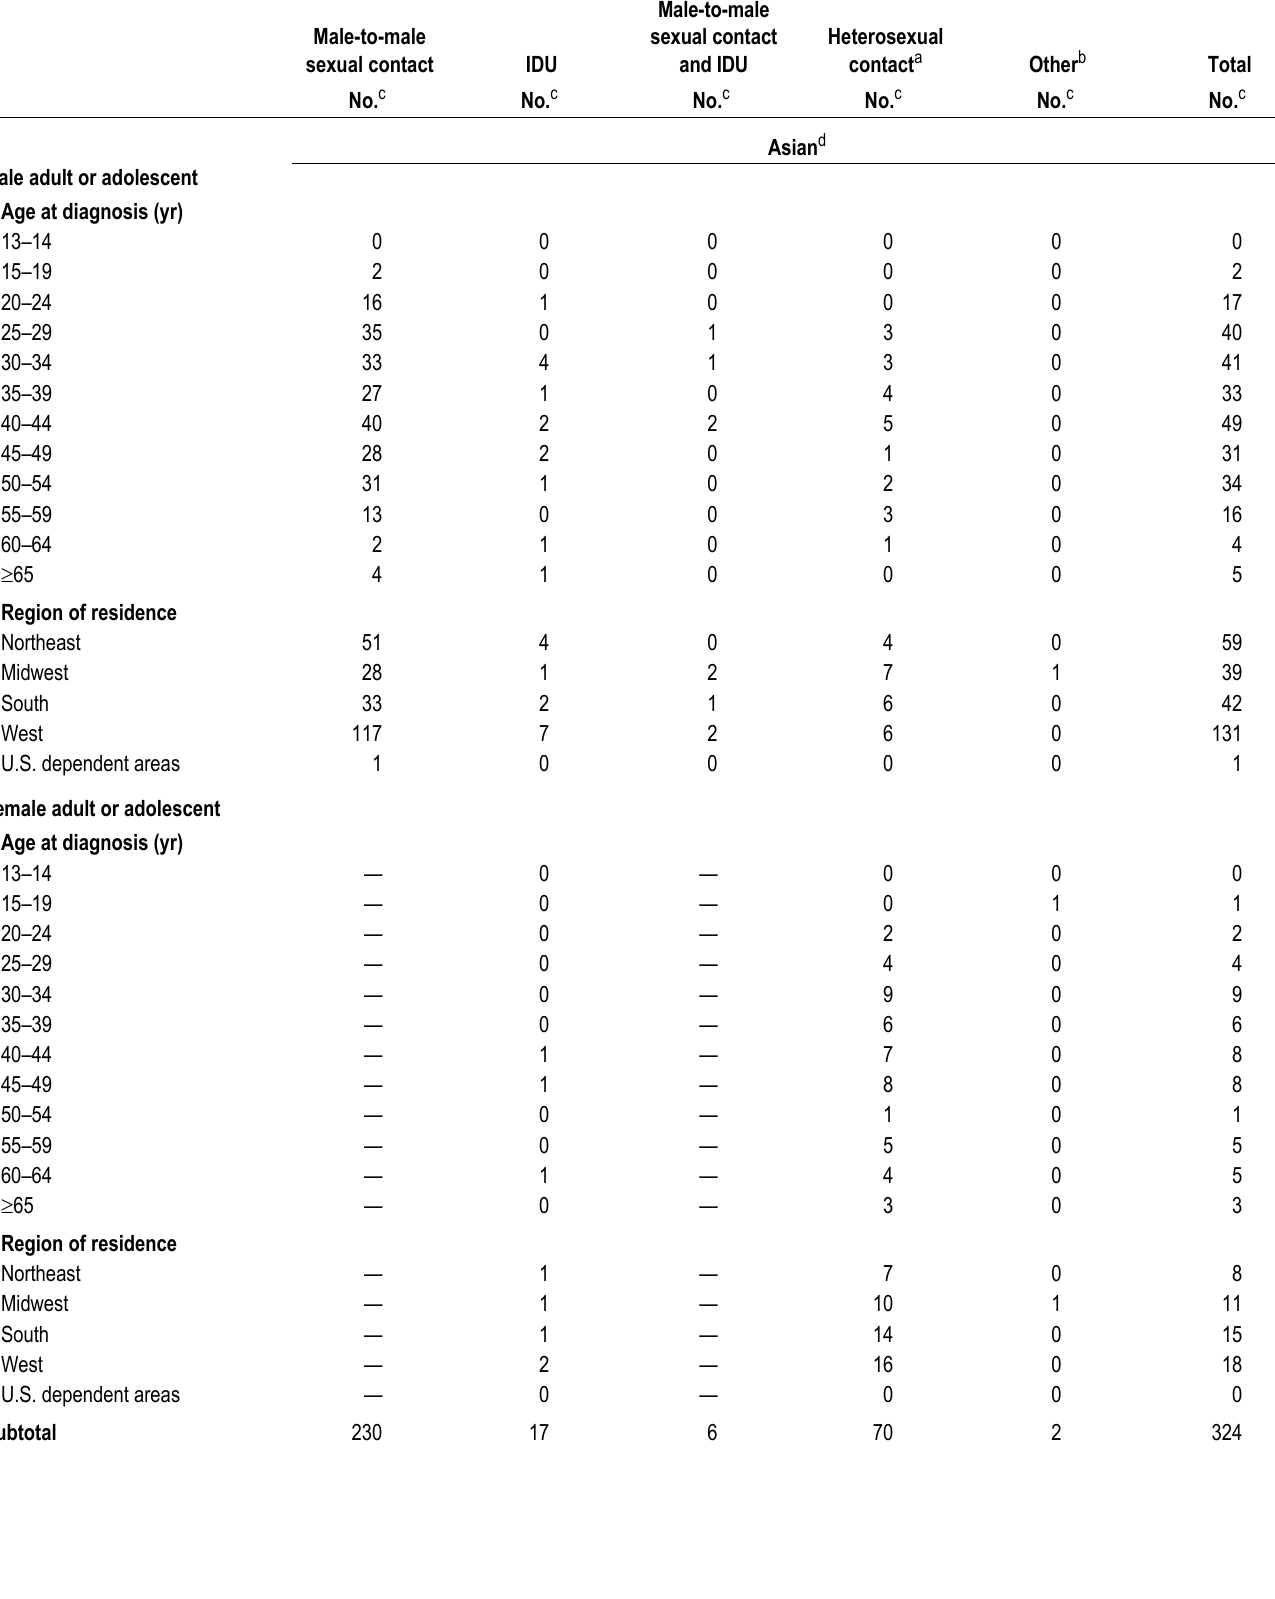
Table 6b. Stage 3 (AIDS), by transmission category, race/ethnicity, and selected characteristics, 2015—United States and 6 dependent areas